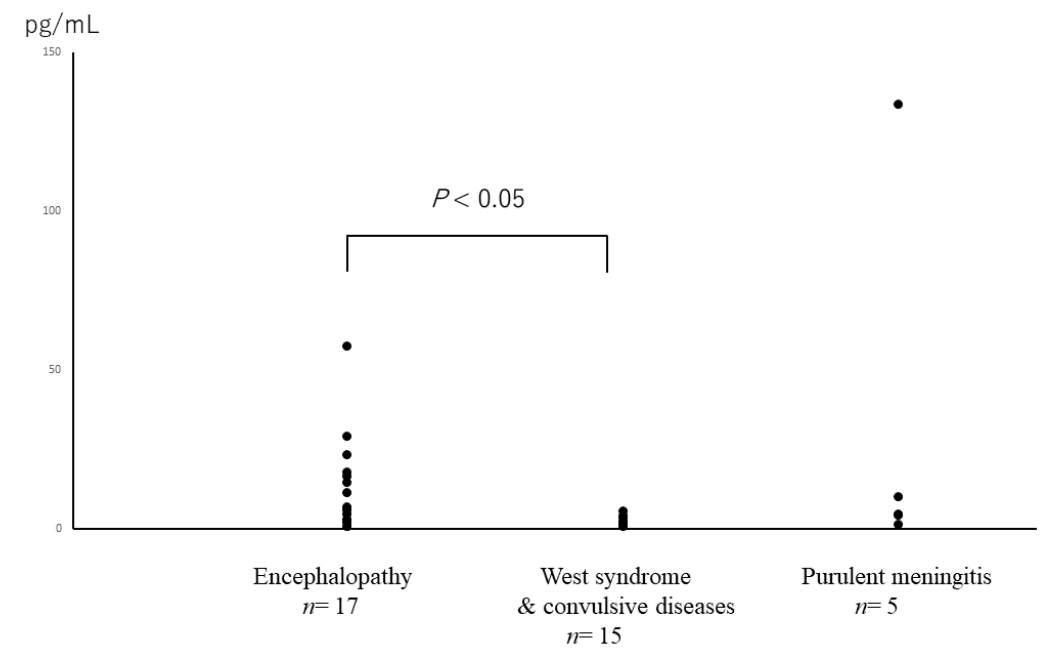
Figure 2. IL-12 (p70) levels in the CSF obtained from patients with different diseases.